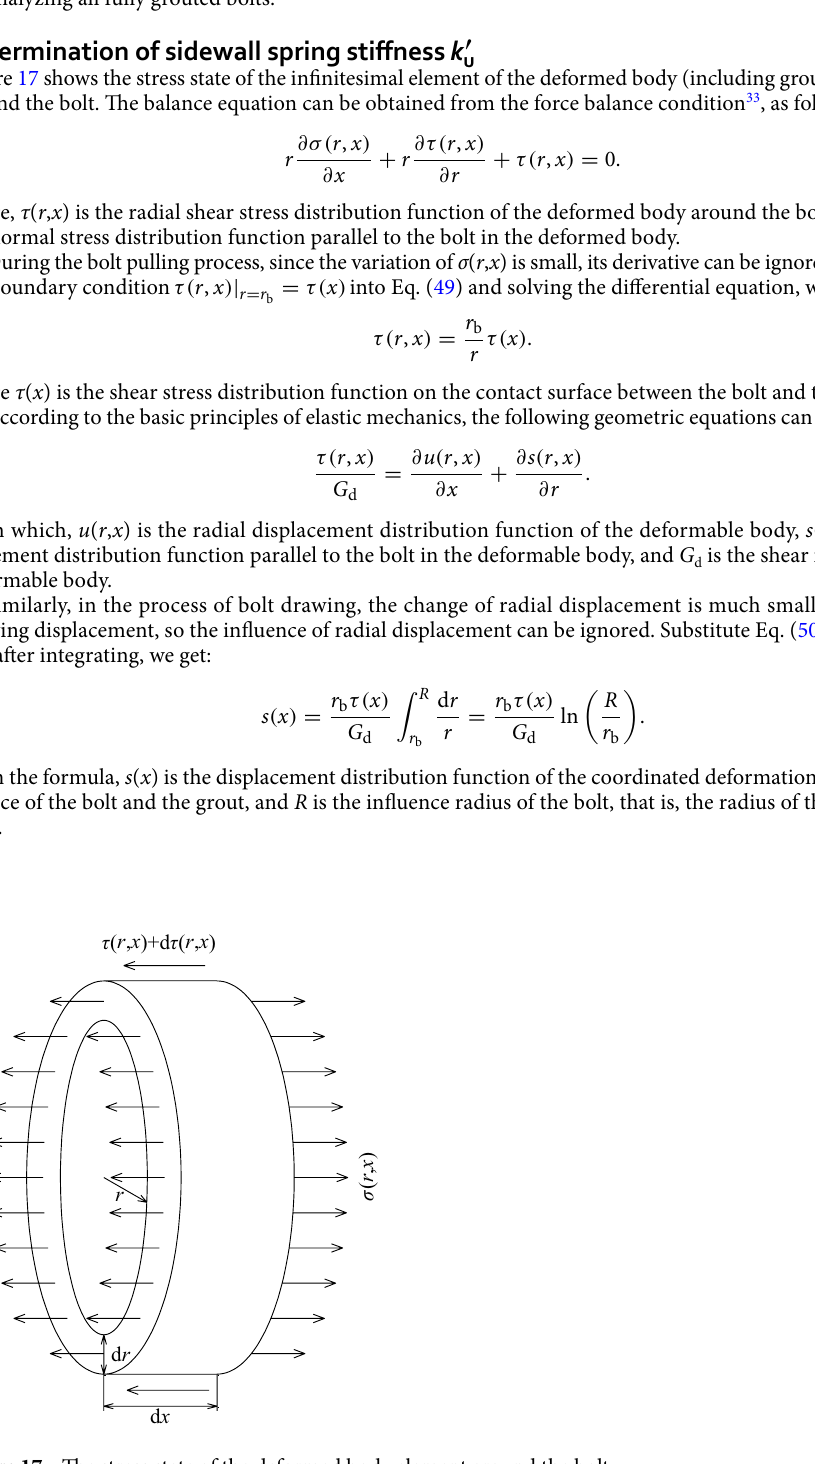
Figure 17. The stress state of the deformed body element around the